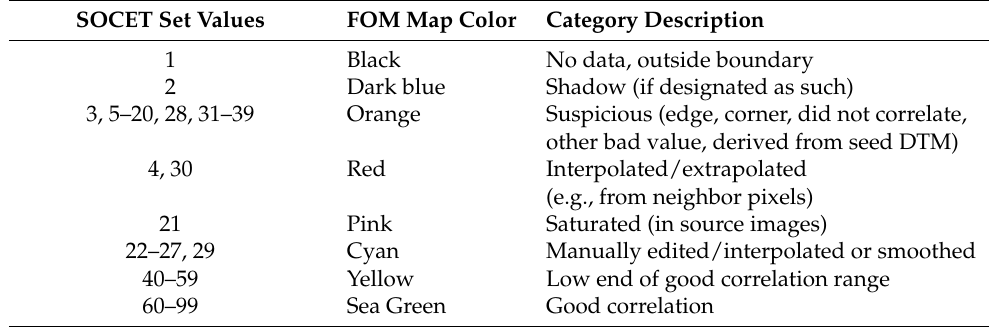
Table A2. FOM values output from SOCET Set, with the corresponding classified map color and